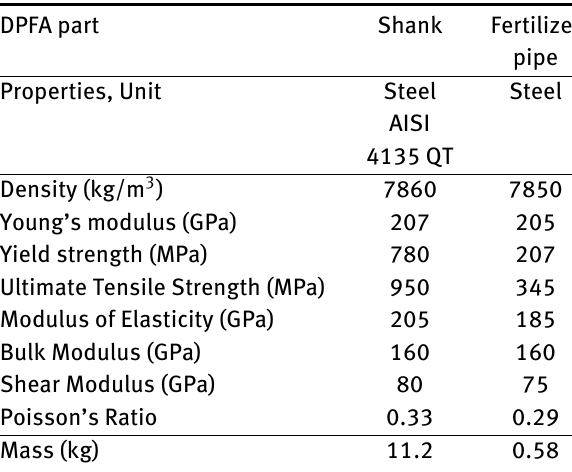
Table 3: Material properties used in the simulation DPFA part Shank Fertilizer